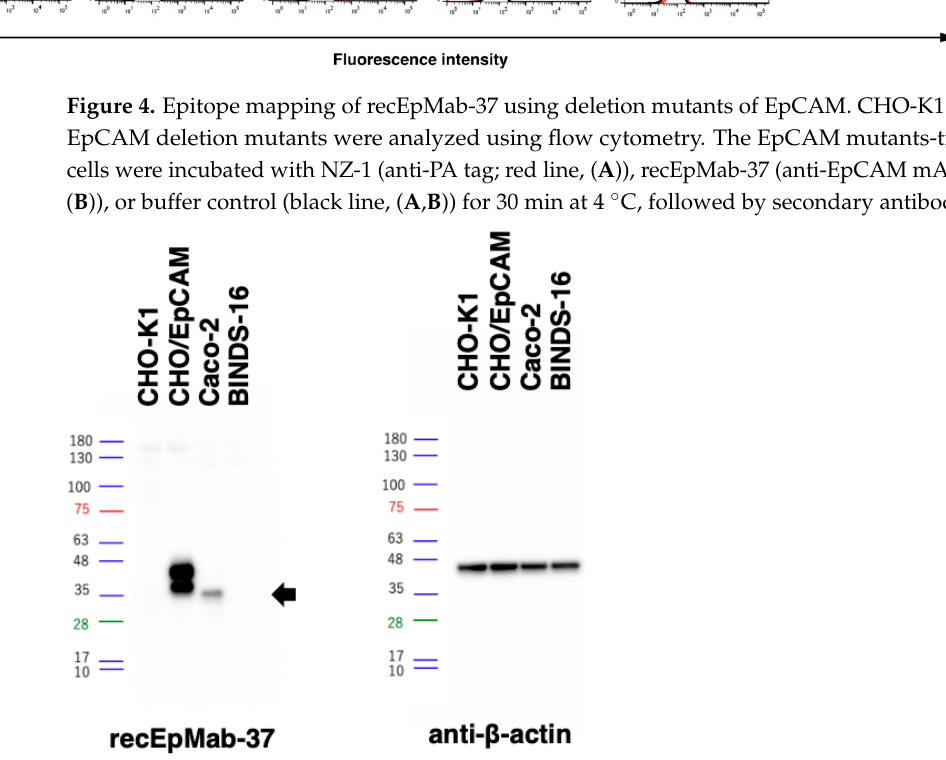
Figure 5. Western blotting by recEpMab-37. Cell lysates of CHO-K1, CHO/EpCAM, Caco-2, and BINDS-16 (10 μ g) were electrophoresed and transferred onto polyvinylidene fluoride membranes. The membranes were incubated with 1 μ g/mL of recEpMab-37 and 1 μ g/mL of anti- β -actin and subsequently with peroxidase-conjugated anti-mouse immunoglobulins. Black arrows indicate the predicted size of EpCAM (~35 kDa).